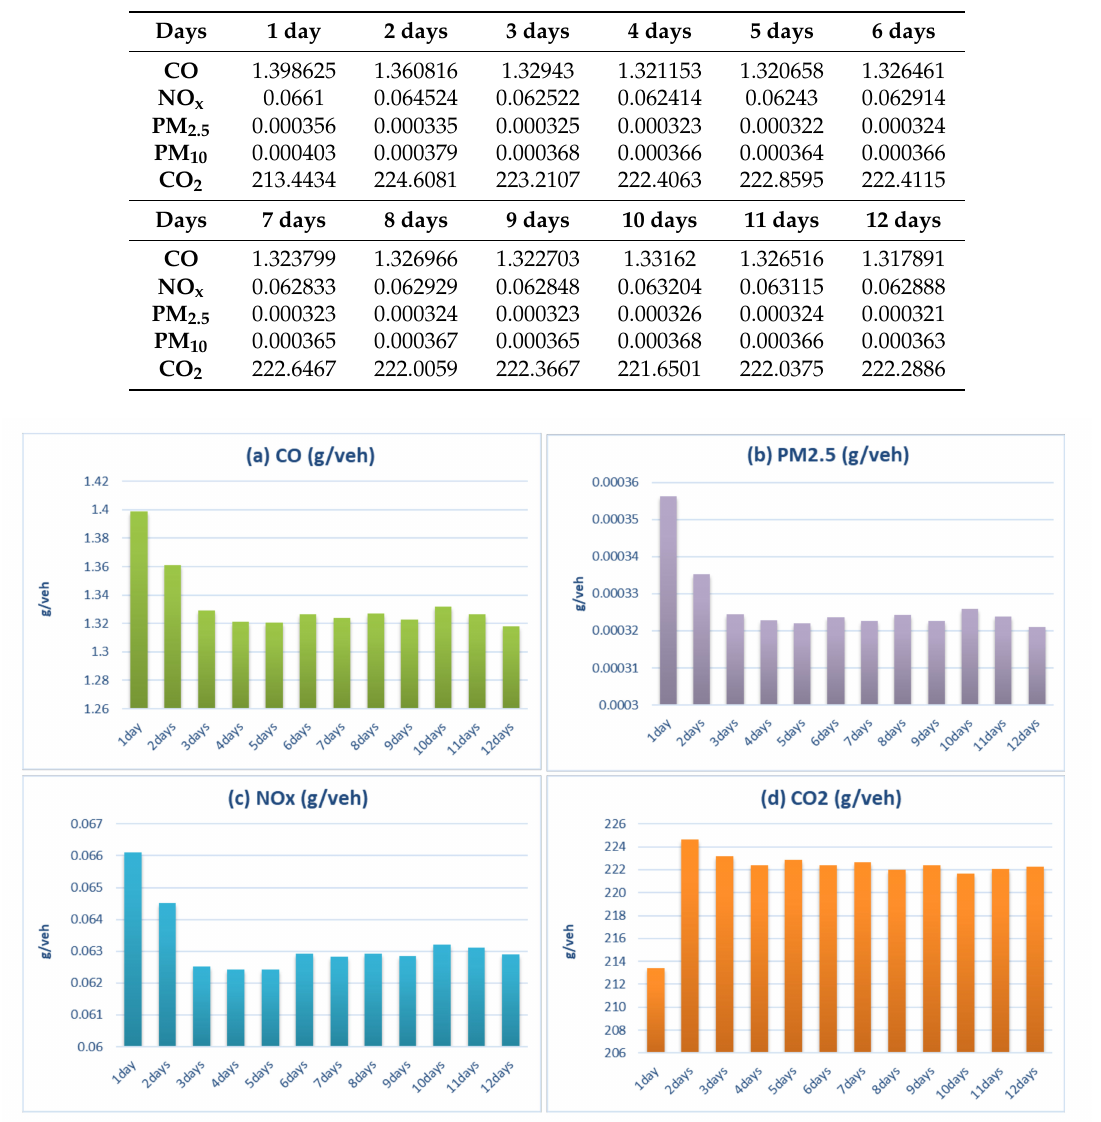
Table 7. Estimated link emission factors (g / veh) by adding number of data collection days.